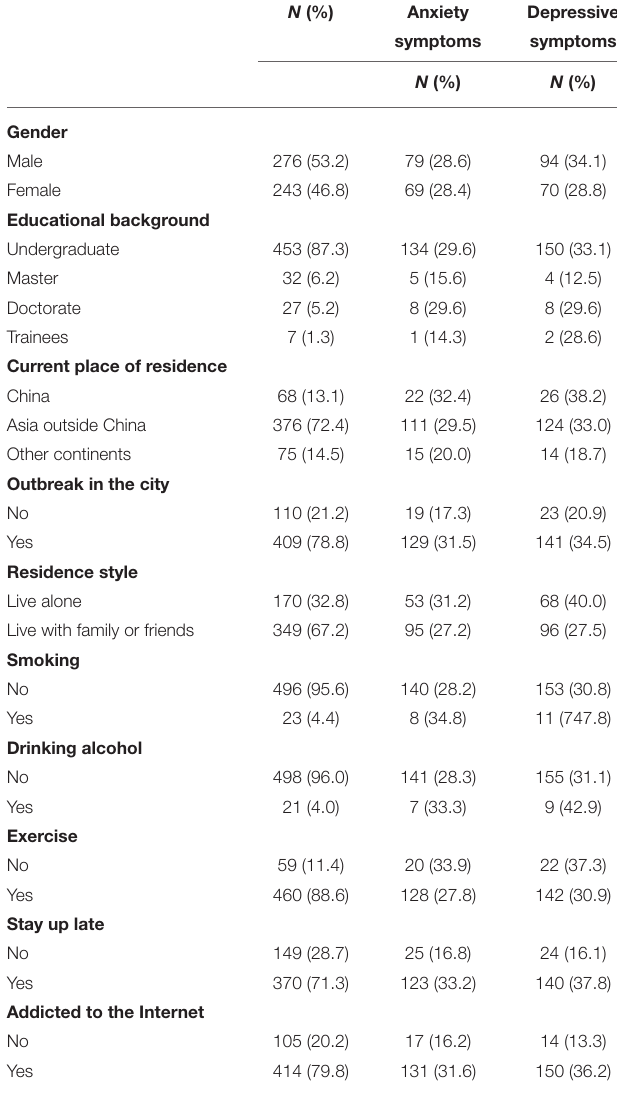
TABLE 1 | Distributions of anxiety symptoms and depressive symptoms in categorical demographic variables ( n =